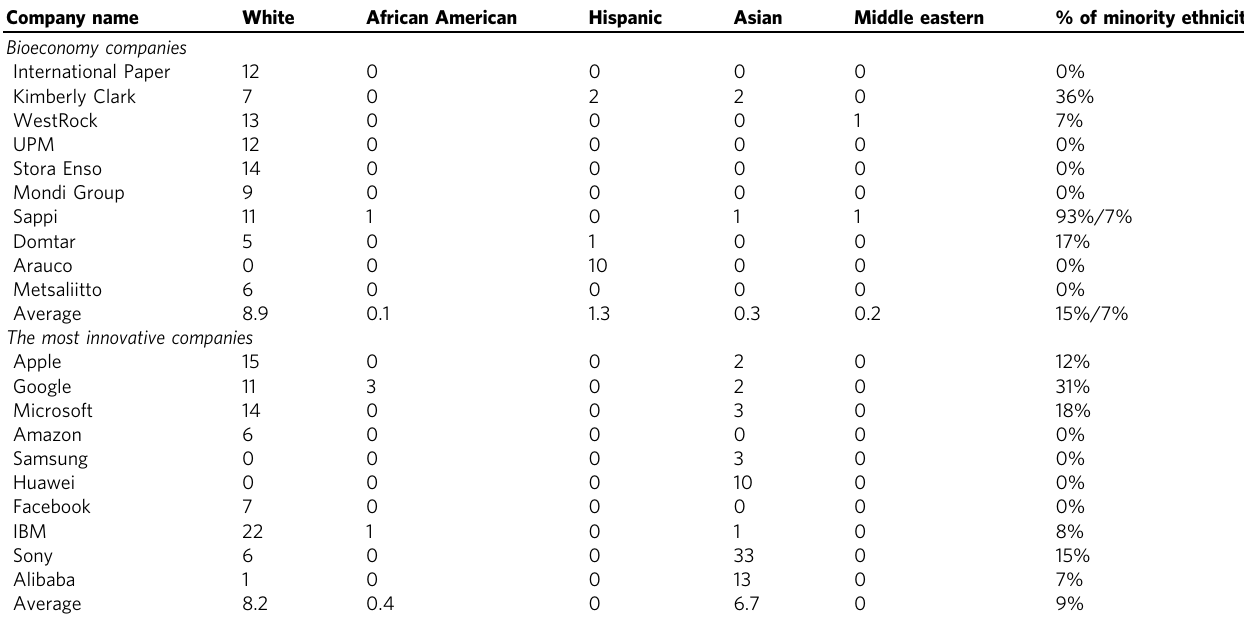
Table 3 Ethnic diversity in the bioeconomy and the most innovative company groups. Company